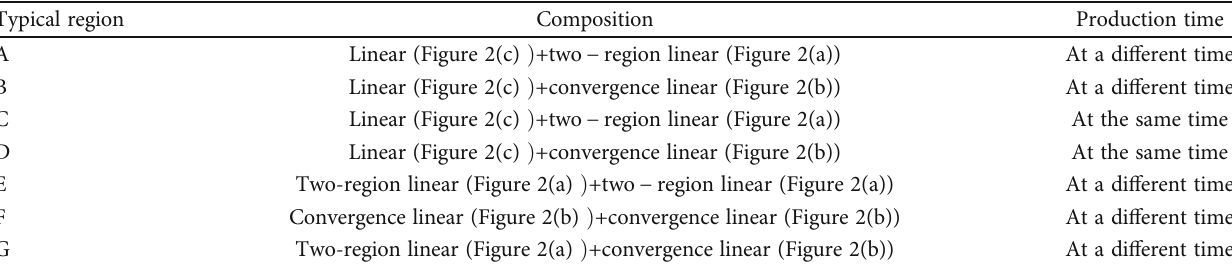
Table 2: The composition of the typical sections shown in Figure 1.